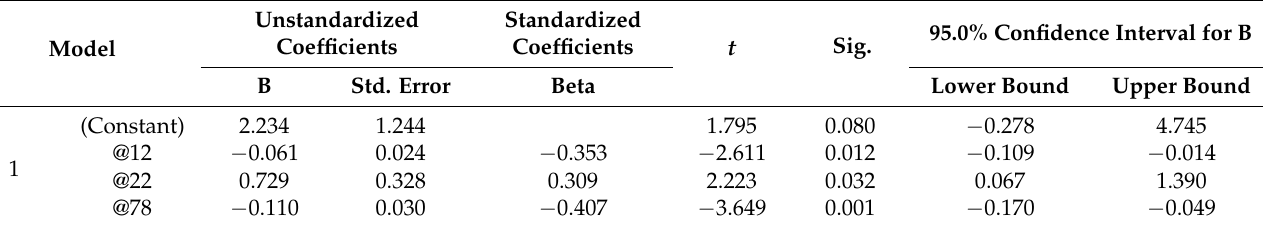
Table 5. The summary table of the regression estimate